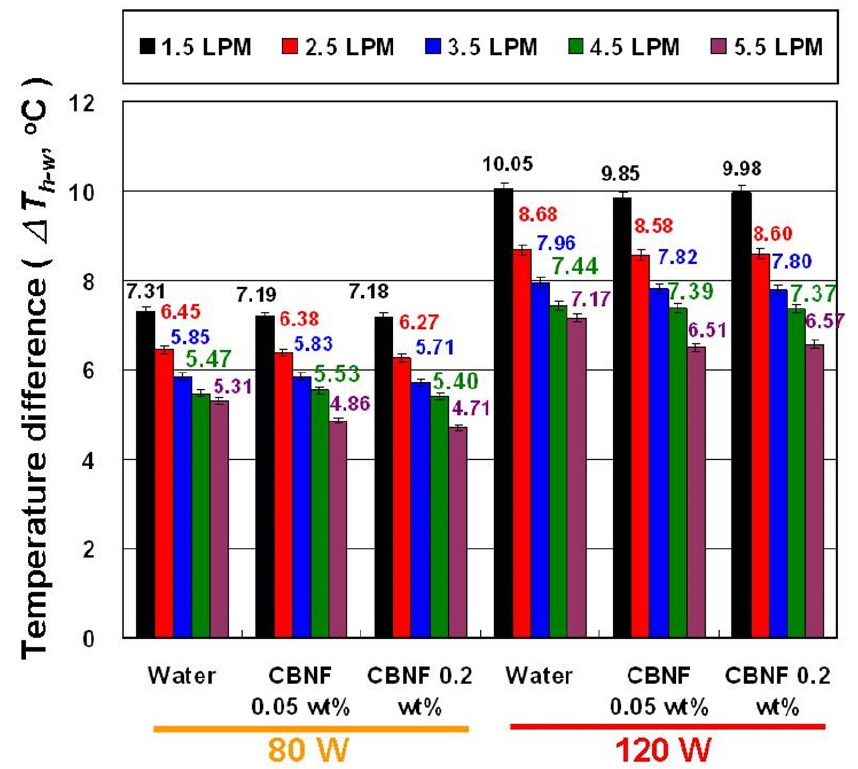
Figure 8. The ∆ T h-w of test samples for THE at various experimental